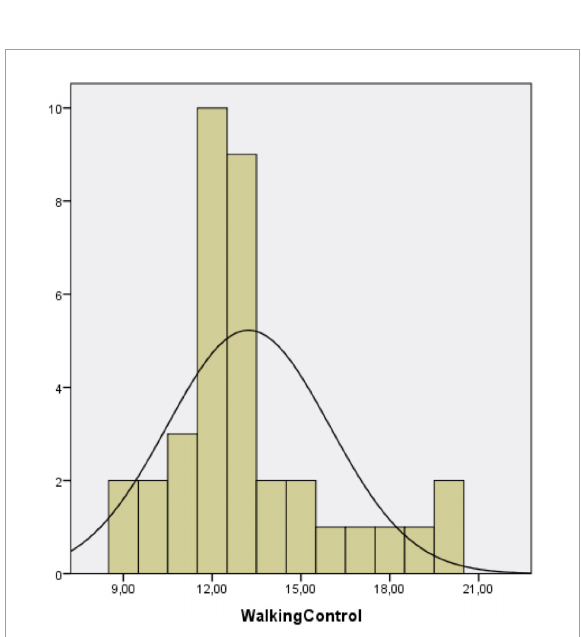
FIGURE1 Study flow-chart.